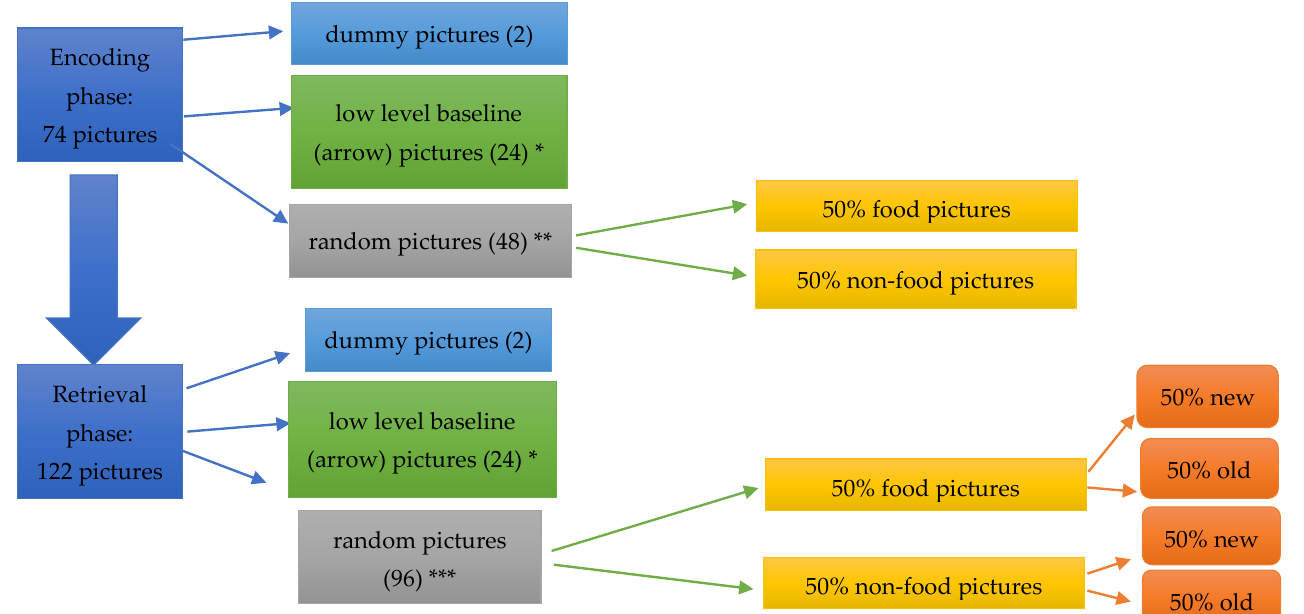
Figure 1. Experimental tasks. * Patients were asked to indicate the direction of the arrow: left of right button. ** Patients were asked to indicate whether pictures were taken indoor (left button) or outdoor (right button). *** Patients were asked to indicate whether pictures were new (left button) or previously seen during the encoding phase (“old”, right button).